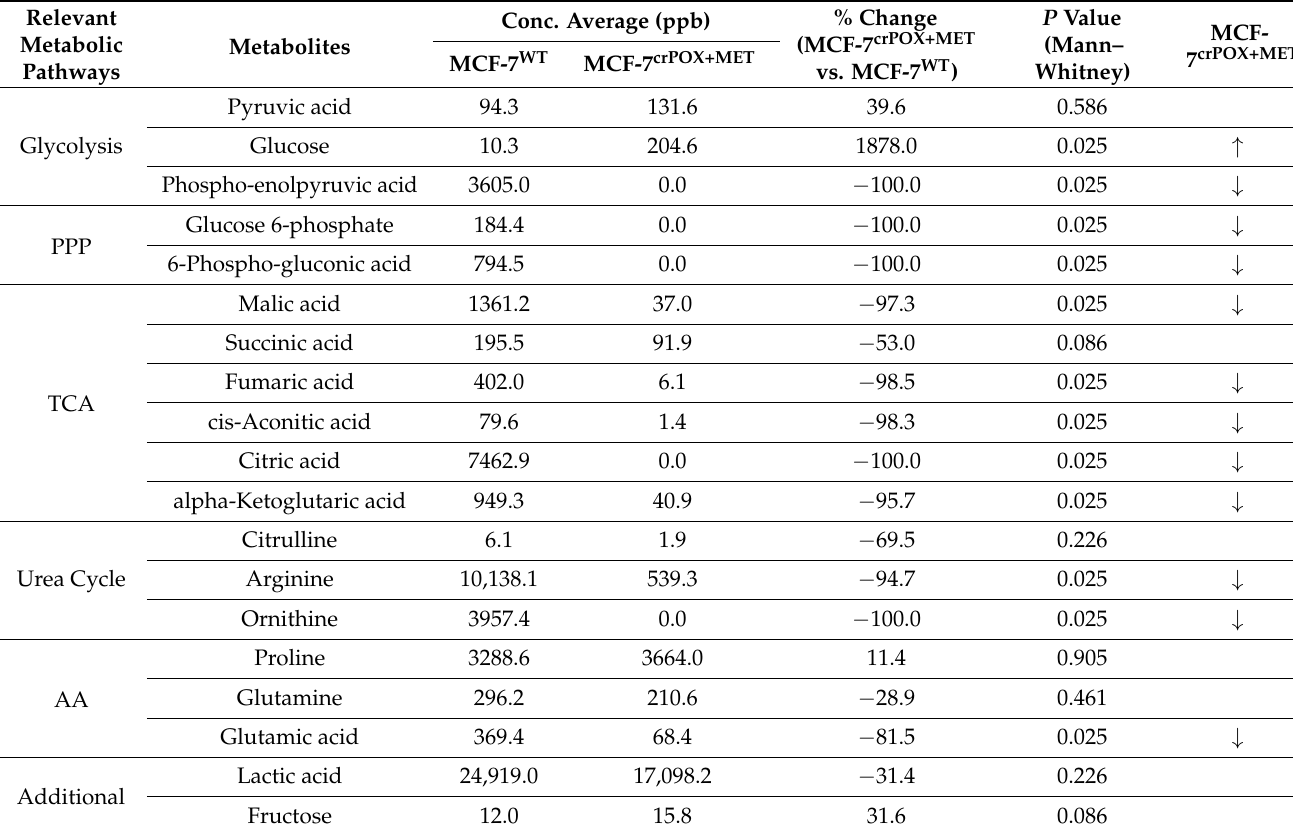
Table 6. Targeted metabolic profiles of some metabolites of glycolysis, pentose phosphate pathway, TCA and urea cycles in MET treated wild type MCF-7 cells (MCF-7 crPOX+ MET ) and in MCF-7 WT cells cultured in medium containing Gln. AA— amino acids, PPP—pentose phosphate pathway, TCA—tricarboxylic acids cycle. ↑ —significant increase in the